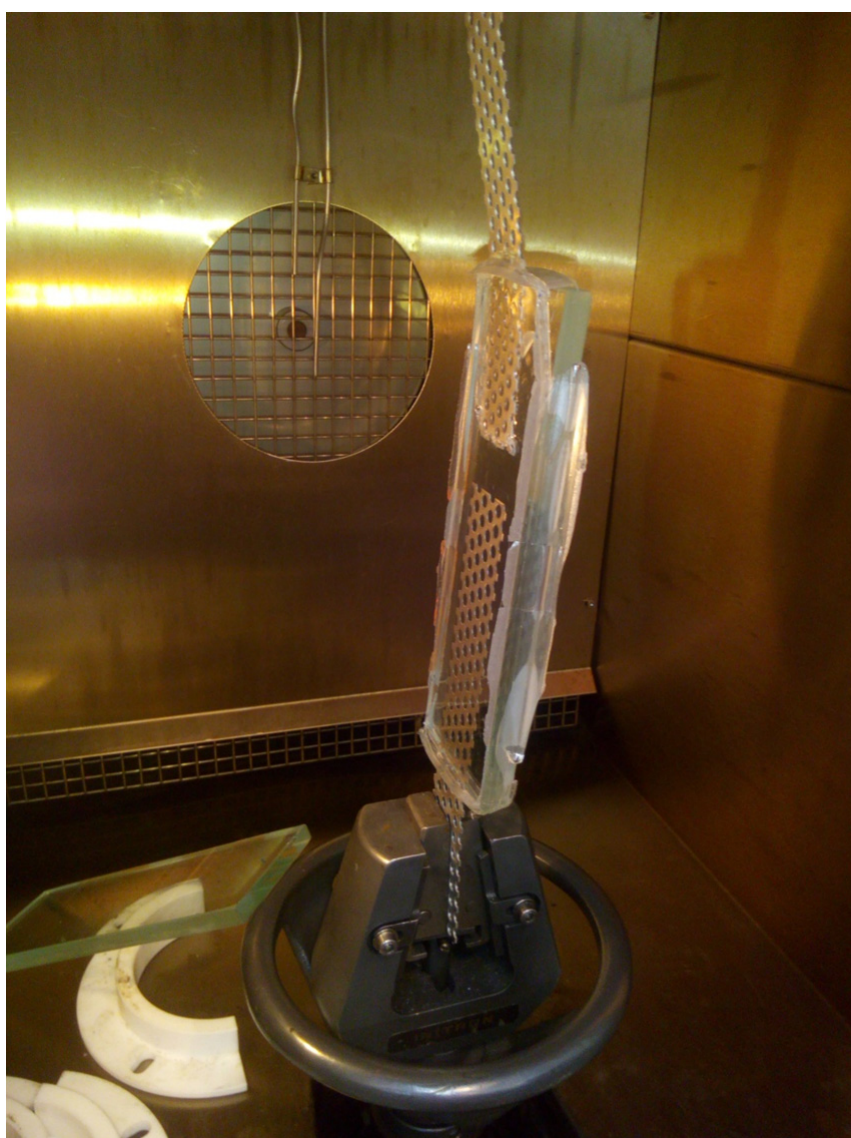
Fig. 13 Specimen 4 after testing at 40 ⁰